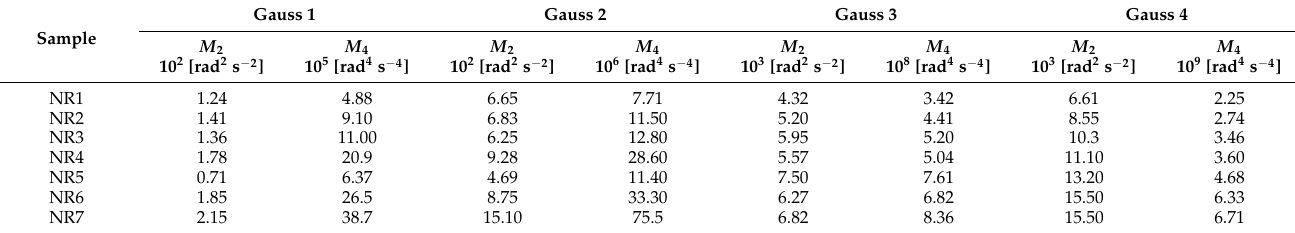
Table 2. The second M 2 and fourth M 4 residual van Vleck moments specific to the Gaussian distributions obtained from the deconvolution of DQ Fourier spectra. Sample